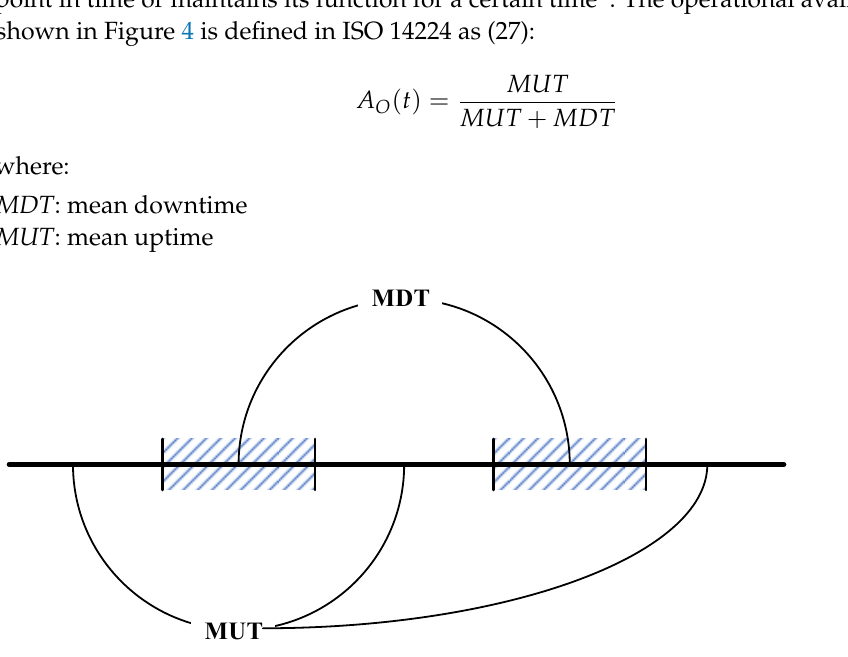
Figure 4. Schematic diagram of availability.